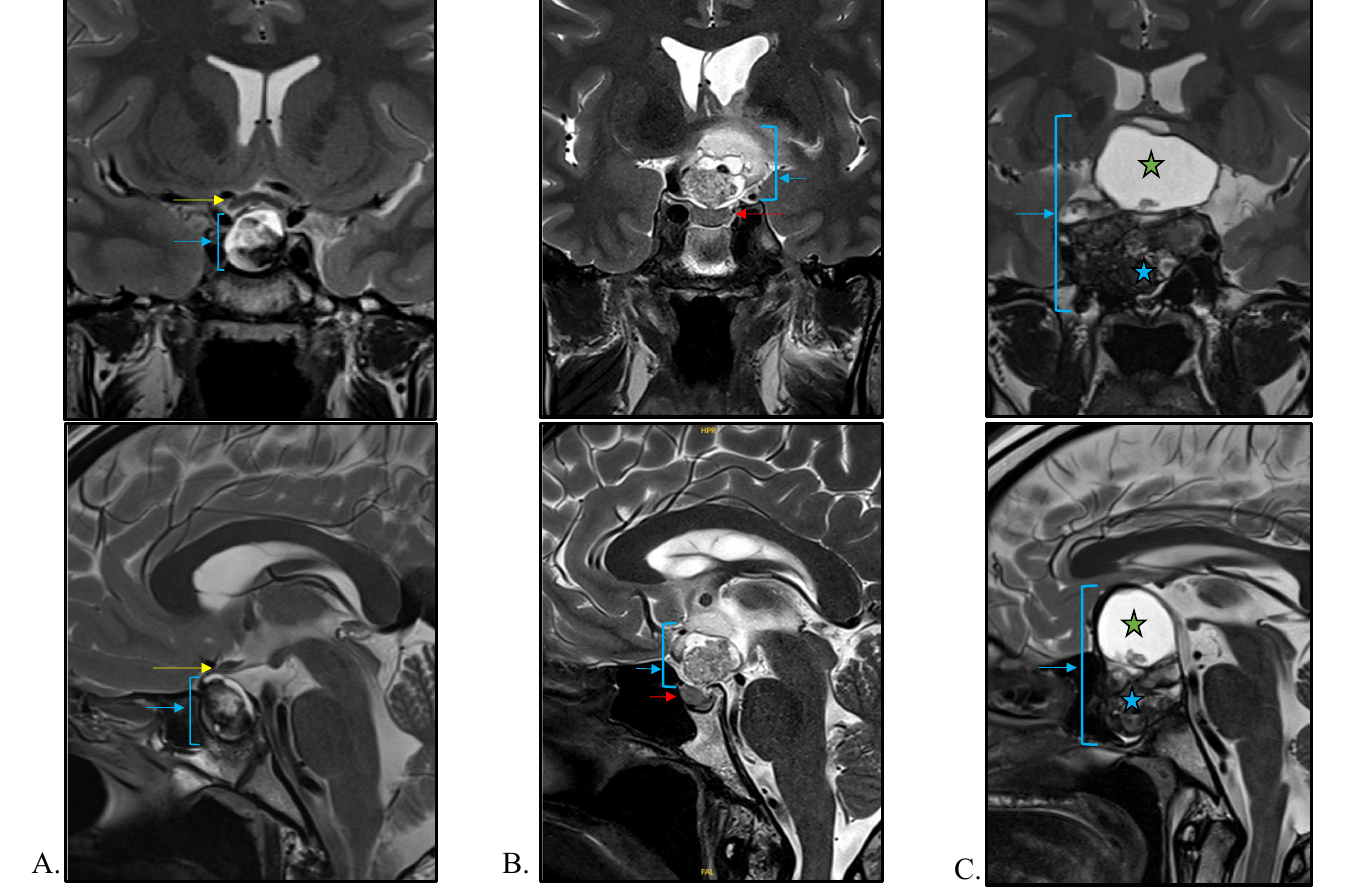
Figure 2. Neuroradiological characteristics of craniopharyngiomas (CP) in T2-weighted coronal and sagittal MRI. ( A ) Intrasellar CP (blue arrow) with a moderate suprasellar extension outcropping the optic chiasm (yellow arrow). ( B ) Exclusively suprasellar CP (blue arrow) showing heterogeneous content and respect to the pituitary gland (red arrow). ( C ) Voluminous CP with invasion of sellar and suprasellar regions (blue arrow). The pituitary gland, stalk, and optic chiasm are no longer visible. The upper part of the tumor is cystic (T2-hyperintensity, green star) while the bottom is fleshy and heterogeneous (blue star).